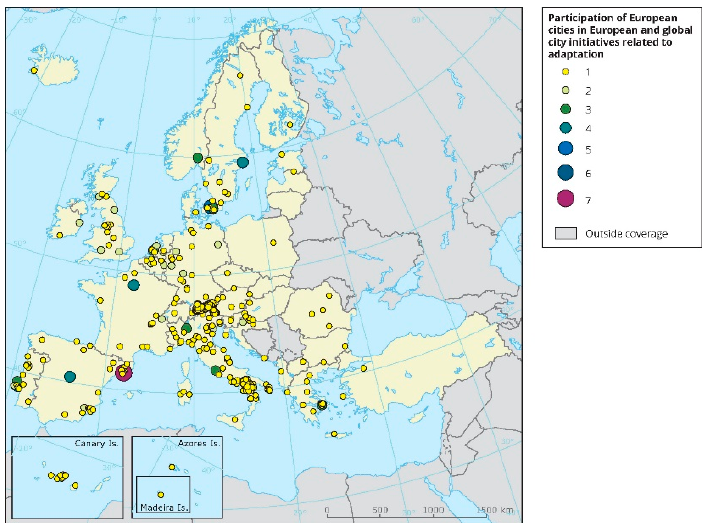
Figure 2. Participation of 650 European cities in European and global city initiatives related to adaptation [57]. The map lists the number of European and international initiatives with a relation to climate-change adaptation in which cities are involved [57]. Source: